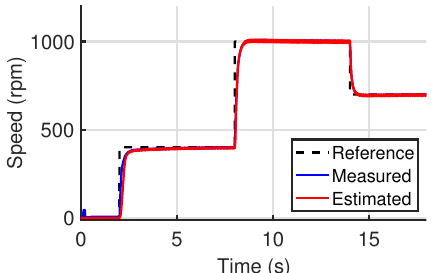
Figure 23. Experimental results of STA at variable speed.